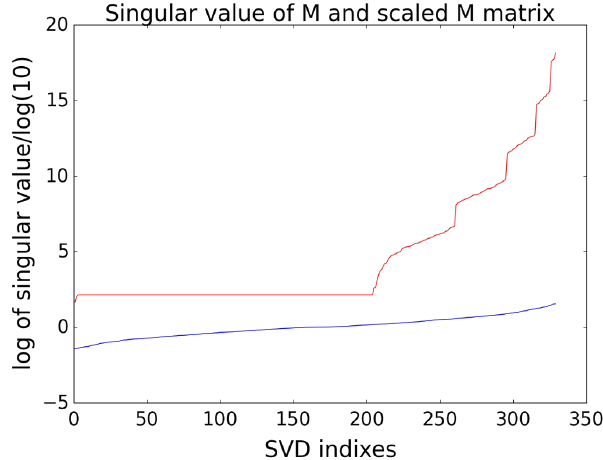
FIG. 16. The range of singular value of the square matrix before (red) and after scaling